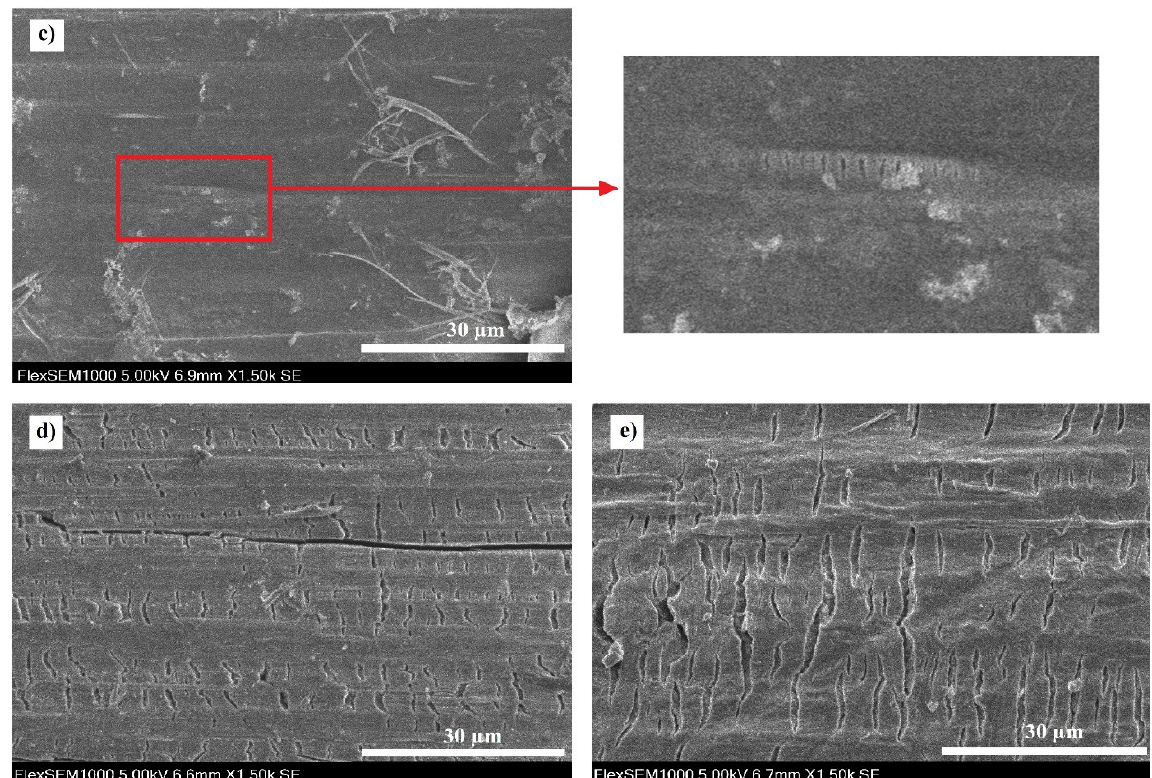
Figure 3. Surface morphology of the stents: ( a ) non−degraded, ( b ) 4−weeks−degraded, ( c ) 8−weeks−degraded, ( d ) 16−weeks−degraded and ( e ) 24−weeks−degraded stent.